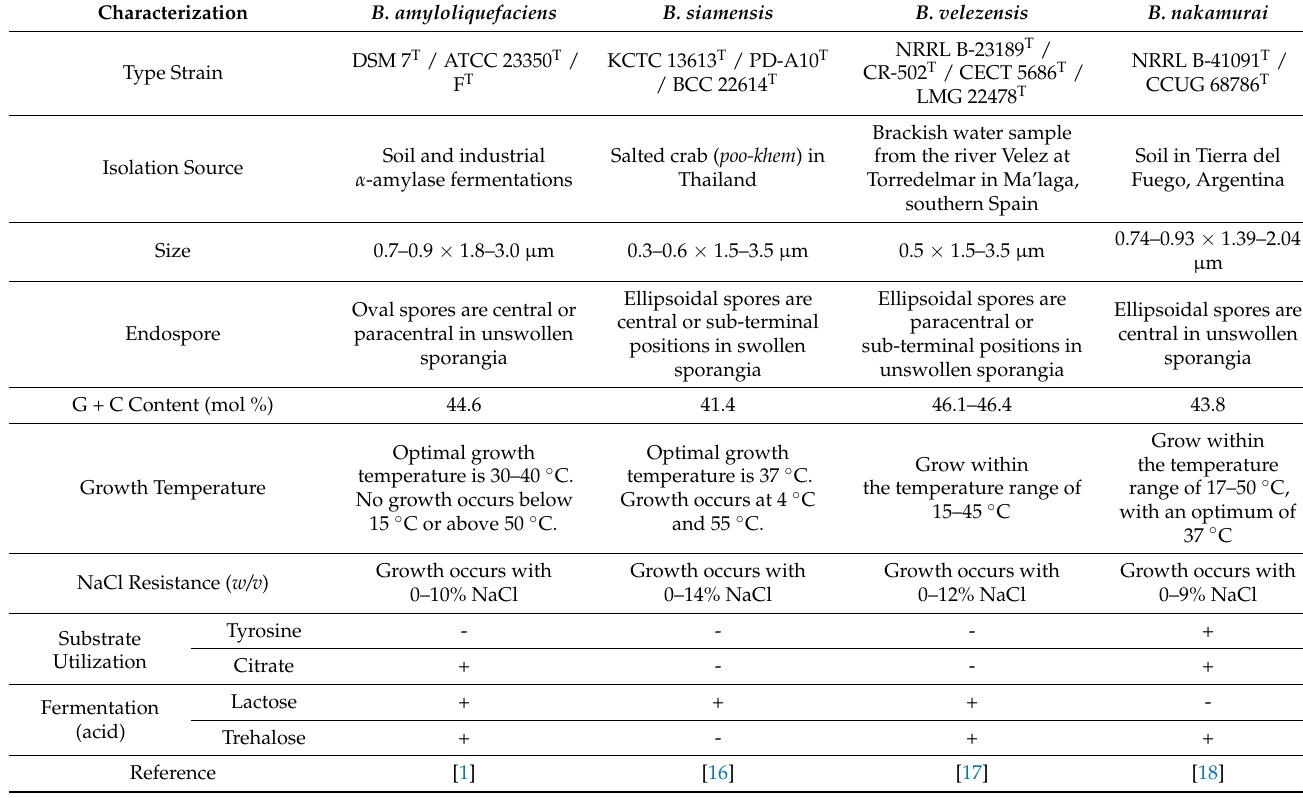
Figure 1. Neighbor-joining phylogenetic tree based on complete rpoB nucleotide sequences of bacterial species under the B. subtilis species complex. Evolutionary analyses were conducted using the MEGAX software [15]. The optimal tree with the sum of branch length = 0.66533958 is shown. The evolutionary distances were computed using the p -distance method. Bootstrap values, based on 1000 repetitions, are indicated at the branch points. The analysis involved 19 nucleotide sequences. There were 3534 positions in the final dataset. Bar, 0.02 substitutions per nucleotide position. Bacillus cereus ATTC 14579 T was used as the outgroup. Table 1. Characterizations of bacterial species under the operational group Bacillus